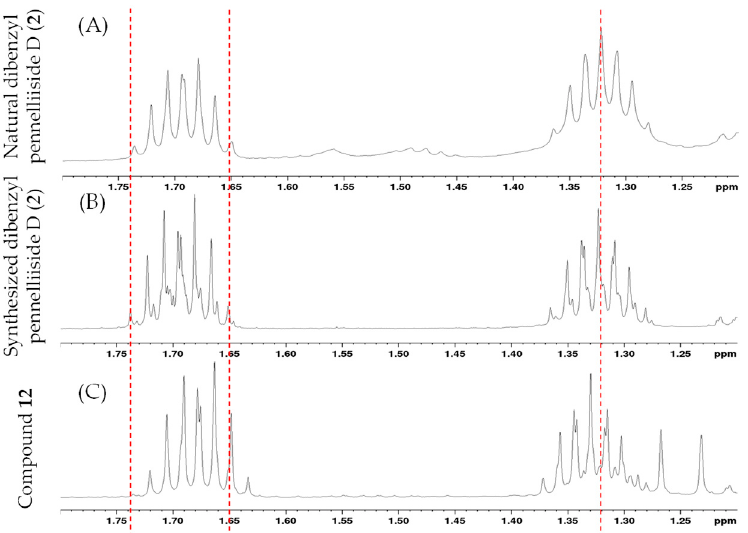
Figure 3. Expanded key 1 H-NMR spectrum for the H-A4 resonances of natural dibenzyl pennelliiside D ( 2 ) and its synthesized isomers ( S / R ). ( A ) 1 H-NMR spectrum of natural dibenzyl pennelliiside D (500 MHz, C 6 D 6 ); ( B ) 1 H-NMR spectrum of the synthesized isomer ( S ) (500 MHz, C 6 D 6 ); ( C ) 1 H-NMR spectrum of the synthesized isomer ( R ) (500 MHz, C 6 D 6 ).